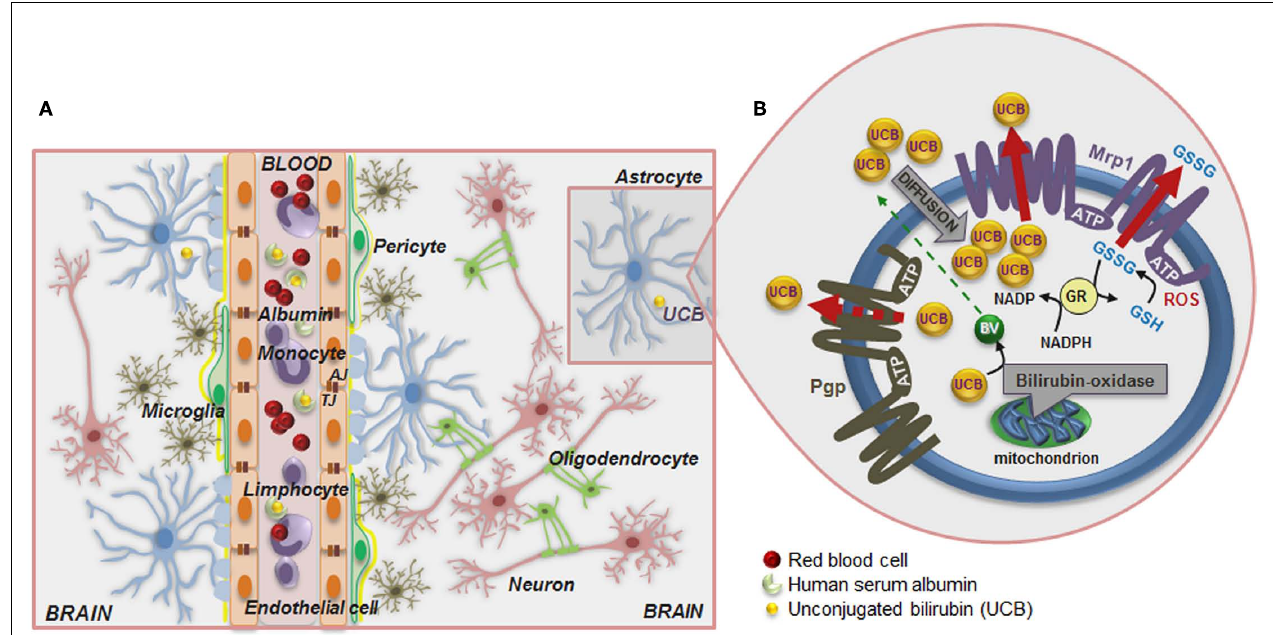
100nM and in the brain are usually lower than 10nM; entrance restriction to UCB is afforded by the P-glycoprotein (Pgp) at the BBB, which is an ATP-dependent cellular export protein of UCB. (B) At the brain cells, UCB is a substrate for the efflux pump multidrug resistance-associated protein 1 (Mrp1) and together with Pgp limit the intracellular accumulation of UCB, mainly in astrocytes. Reduced expression of Pgp and Mrp1 in young astrocytes and neurons, as well as in Gunn rats’ pups, probably account to the vulnerability of premature babies to UCB. A high intracellular concentration of glutathione (GSH) protects against reactive oxygen species (ROS). GSH is regenerated from glutathione disulfide (GSSG) in a reaction catalyzed by glutathione reductase (GR) using NADPH as a second substrate. Astrocytes release GSSG under oxidative stress via Mrp1. Another protective mechanism against UCB toxicity is the mitochondrial membrane enzyme bilirubin oxidase which in the presence of molecular oxygen converts UCB to biliverdin (BV) and other products that are much less toxic than UCB. Changes in BBB integrity will lead to UCB entrance into the brain, and failure of cell defensive mechanisms against UCB toxicity will favor brain